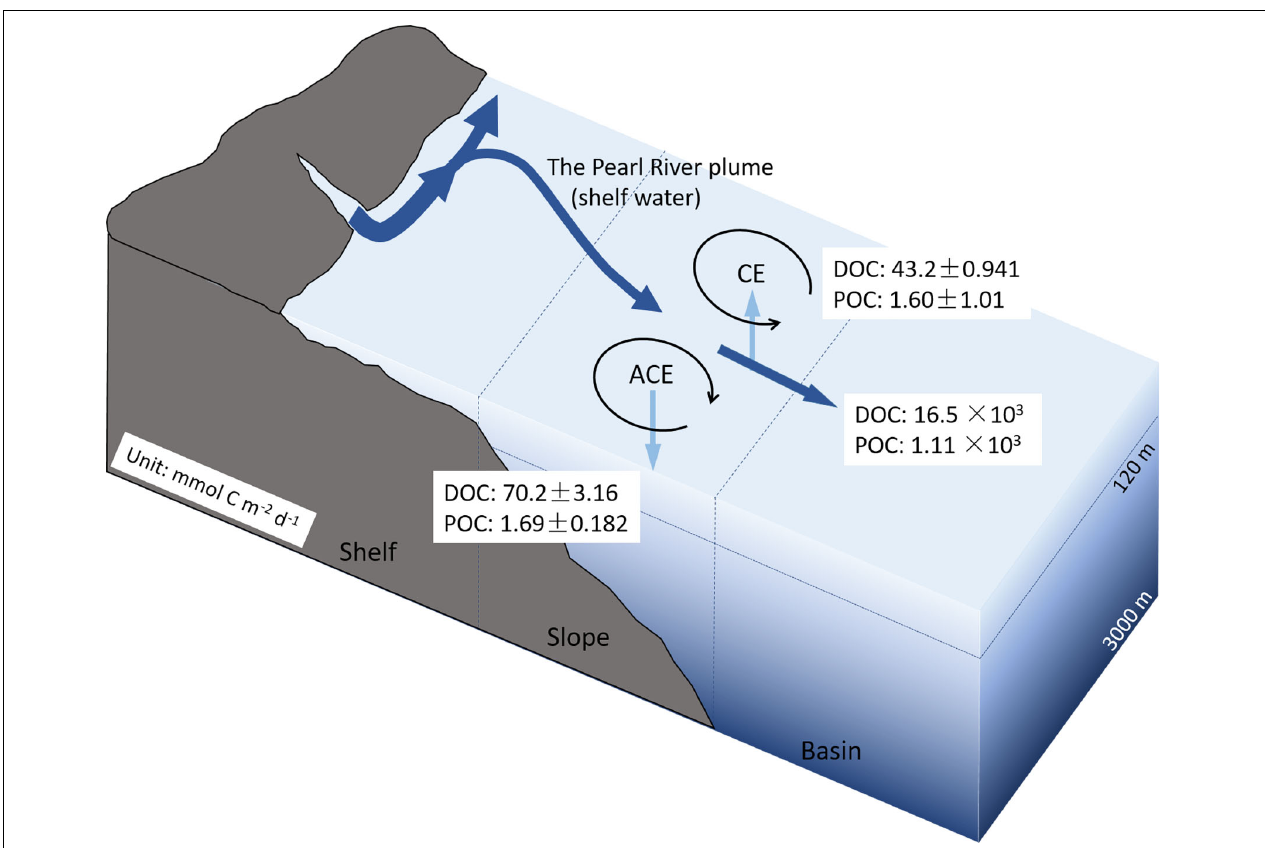
FIGURE 7 | The conceptual diagram of the vertical and horizontal export rate of organic carbon in the northern slope of the SCS driven by dual eddies. ACE, anticyclonic eddy; CE, cyclonic